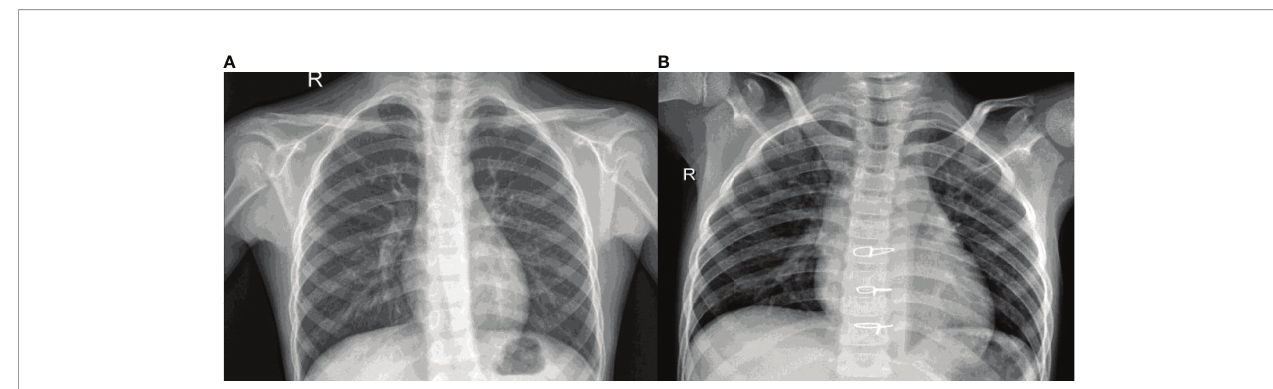
FIGURE 1 | X-ray images of the lungs (A) Healthy chest X-ray (B) Pneumonic chest